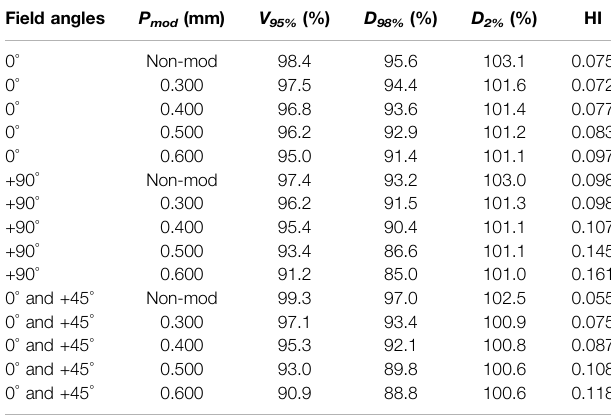
TABLE 3 | Dosimetric indices for carbon ion treatment plans for P2 with ρ range of 0.1 – 0.5 g/cm 3 and different planning parameters. Field angles